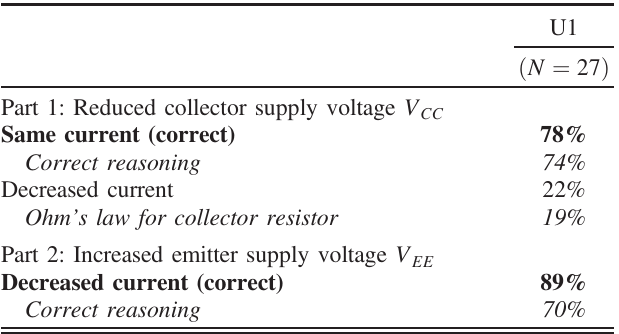
TABLE IV. Overview of student performance on the transistor supply voltage modification task (shown in Fig. 7). Correct responses on each part are indicated by bold text.